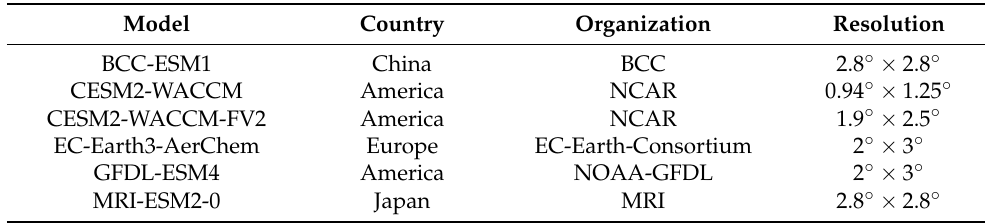
Table 1. Summary information of six CMIP6 global climate models. Model Country Organization Resolution BCC-ESM1 China BCC